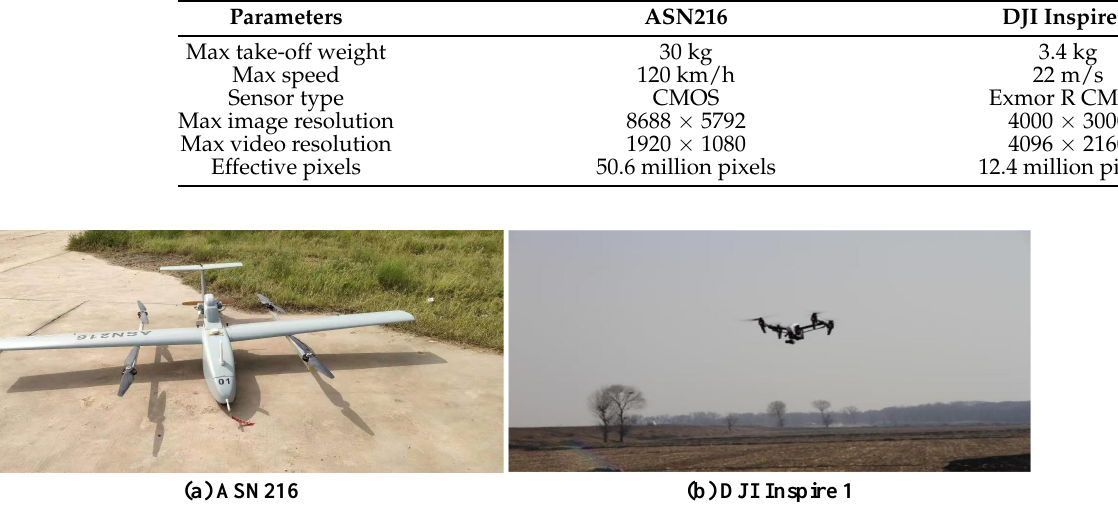
Figure 2. Photographs of fixed-wing UAV ASN216 and DJI Inspire 1.